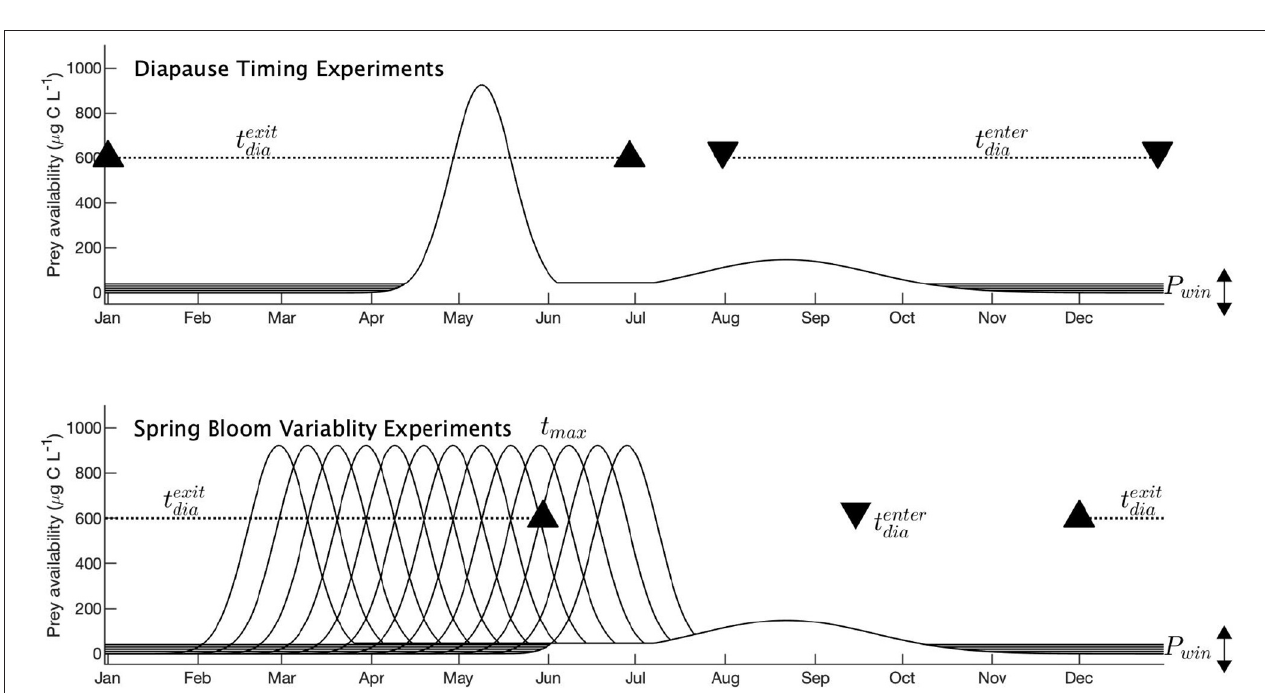
FIGURE 5 | Experimental setup of the Coltrane model for two experiments: Diapause Timing Experiments and Spring Bloom Variability Experiments. Black solid lines indicate prey availability. Black triangles and dashed lines show diapause conditions: black triangles indicate the date of diapause entry ( t enter dia , downward triangles) and diapause exit ( t exit dia , upward triangles). Dashed lines show the variation allowed with some parameter values. No dashed line indicates a fixed date.